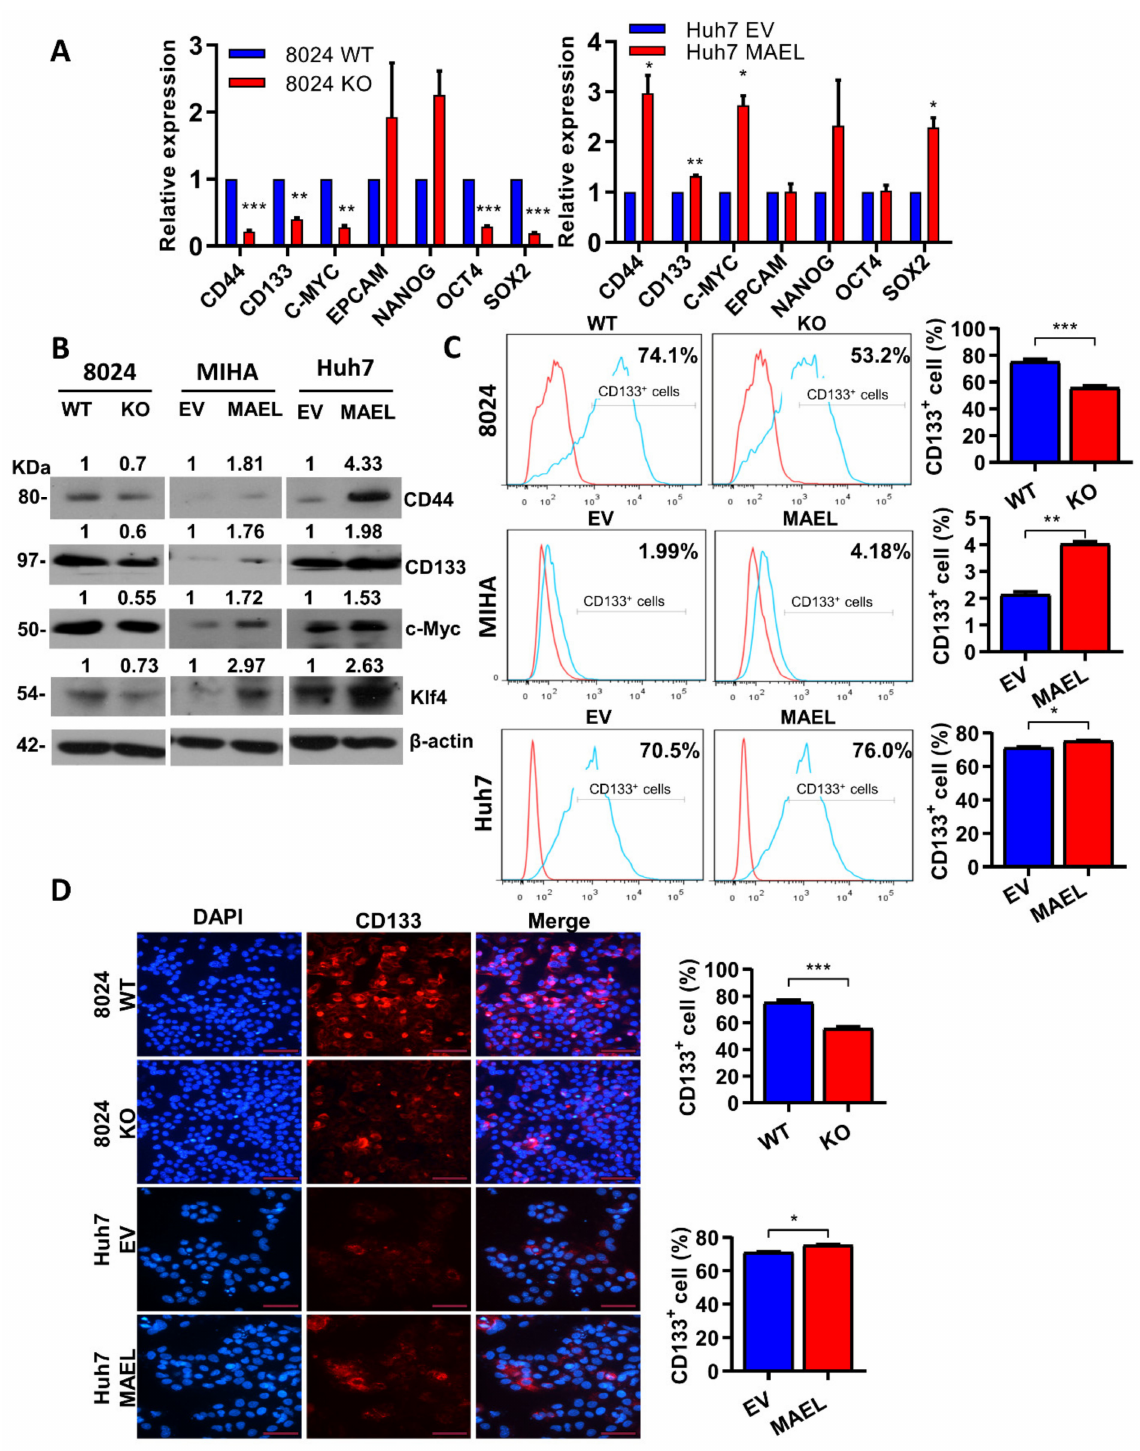
Figure 3. MAEL increased stemness-associated gene expression in HCC cells. Relative mRNA ( A ) and protein ( B ) expressions of stemness-related genes in MAEL overexpression or knockout cells. β -Actin and 18s RNA served as a loading control. Full Western Blot can be found in Figure S7. ( C ) Representative flow cytometry histogram and quantification of CD133 + population in cells with or without MAEL modulation. ( D ) Representative immunofluorescent images and quantification of number of CD133 + PLC8024 and Huh7 cells with or without MAEL modulation. Scale bar stands for 50 µ m. The values indicate the mean ± SD of three independent experiments. * p < 0.05; ** p < 0.01; *** p <